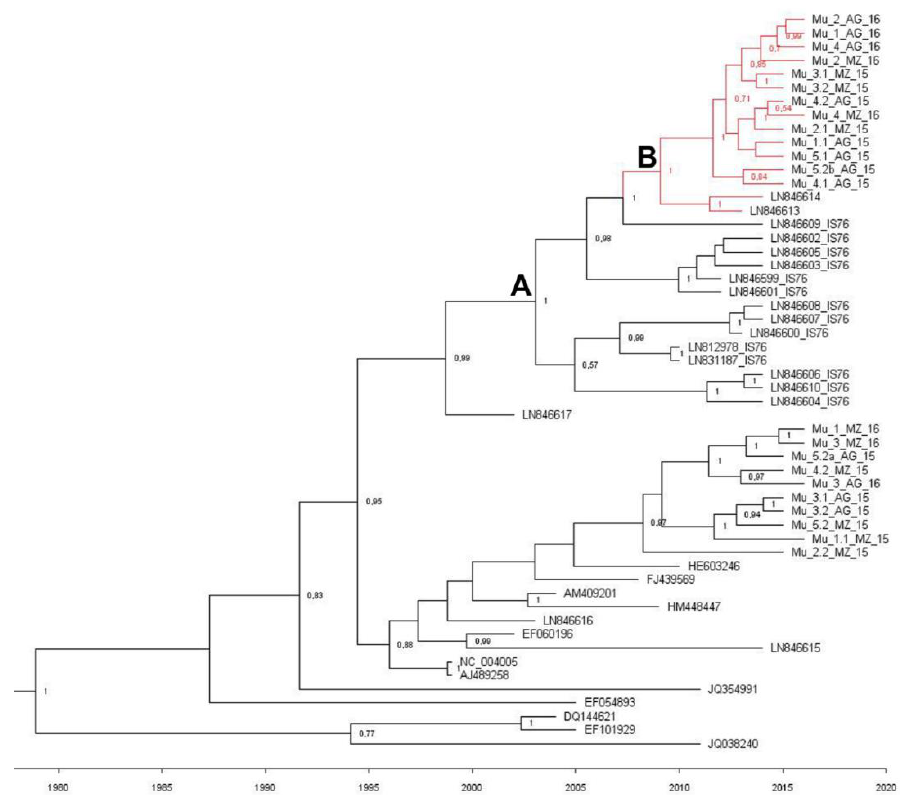
Figure 5. Maximum clade credibility tree reconstructed from the Spanish, Moroccan, and selected Tomato yellow leaf curl virus strain Israel (TYLCV-IL) nucleotide sequences dataset. The genomic region recombined in TYLSV-IS76 isolates was excluded from the alignment. Each taxon was named according to the GenBank accession number of its sequence except the taxa identified in this study, which were named with their sequence codes (Table 1). The time-scale is indicated below the tree. Node labels correspond to posterior probability support values (values below 40% are not shown). The branches supporting the El Jadida/Murcian Group 2 clade are colored in red. Node B corresponds to the most recent common ancestor of the parental genome of El Jadida/Murcian Group 2 and node A to the most recent common ancestor of TYLCV-IS76 Moroccan recombinants and El Jadida/Murcian Group 2.